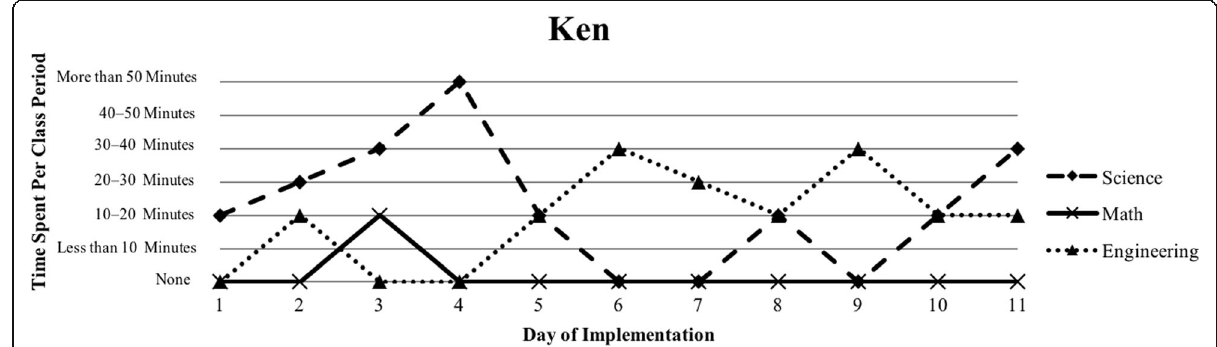
Fig. 3 Ken ’ s implementation of the Particle Nature of Matter in his 6th grade science class